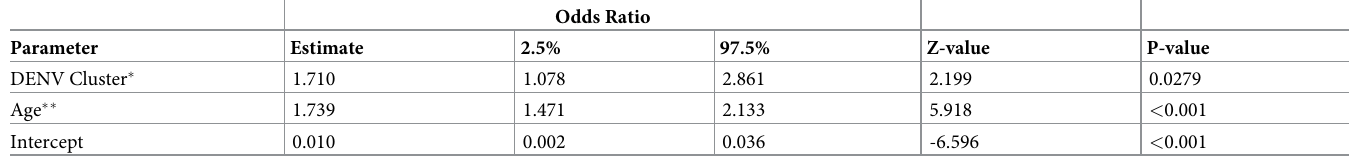
Table 1. Odds ratio estimated from a mixed-effects logistic regression model evaluating the association between DENV seroprevalence in cohort participants aged 8 or younger and their location of residence (2008–2015 DENV clustering area).